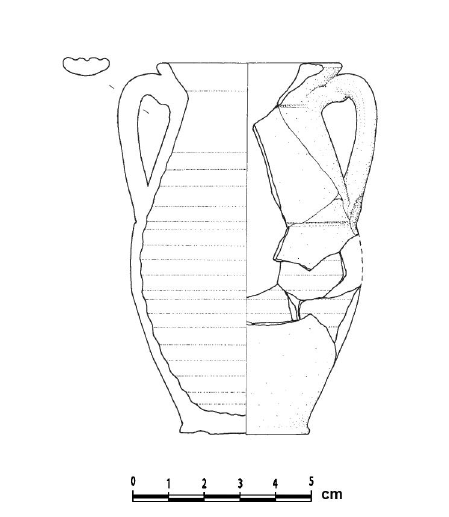
Figure 6: Example of a double handled vessel from southern